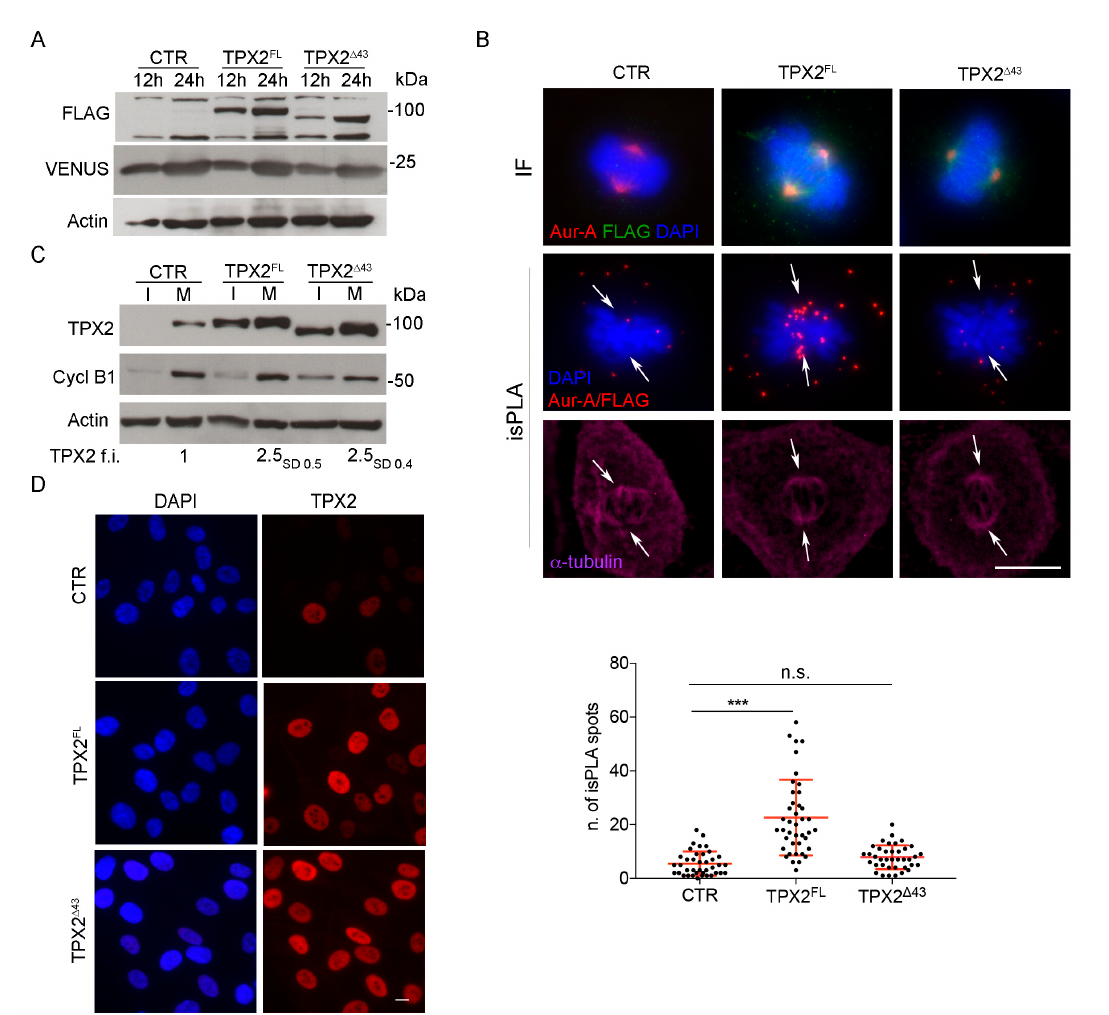
Figure 1. Generation of hTERT RPE-1 stable cell lines overexpressing TPX2 full length (FL) or Δ 43. ( A ) Western blotting (WB) analysis shows exogenous TPX2 (FLAG-tagged) in the indicated cell lines, after 12 and 24 h of dox induction. Levels of the fluorescent VENUS protein are also shown; actin is used as loading control. ( B ) Upper immunofluorescence (IF) panels show the localisation of Aurora-A and FLAG-tagged proteins in mitosis in the indicated cell lines (the green signal comes from anti-FLAG staining, while VENUS fluorescence was lost due to methanol fixation); in situ proximity ligation assay ( is PLA) signals corresponding to the FLAG/Aurora-A interaction are shown in the panels below. Arrows indicate the position of spindle poles, as assessed by α -tubulin staining. Quantification of the number of is PLA spots within the spindle area under the different conditions are also shown (measures from at least 40 mitoses from three independent experiments; standard deviations (s.d.) are shown; *** p < 0.0001, n.s. (not significant) p ≥ 0.05, one-way ANOVA, Tukey’s multiple comparisions test. ( C ) Total levels of TPX2 in the indicated cell lines in extracts from interphasic (I) and mitotic (M) cells, 12 h after induction with dox; cyclin B1 is used as a cell cycle control, actin as a loading control. Average fold increase (f.i.) of TPX2 levels in mitotic extracts is shown; subscripts indicate s.d. Molecular weights are indicated on the right side of the WB panels ( A , C ). ( D ) IF panels show interphase localisation and increased level of total TPX2 in the indicated cell lines after 12 h of dox induction. Scale bars: 10 μ m.